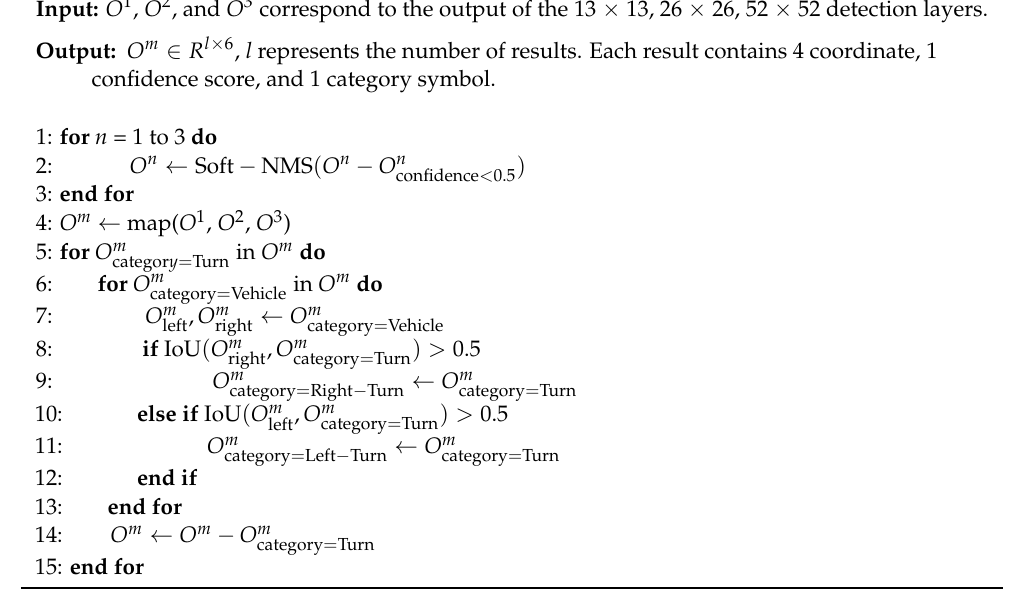
Algorithm 1 Output Decoding